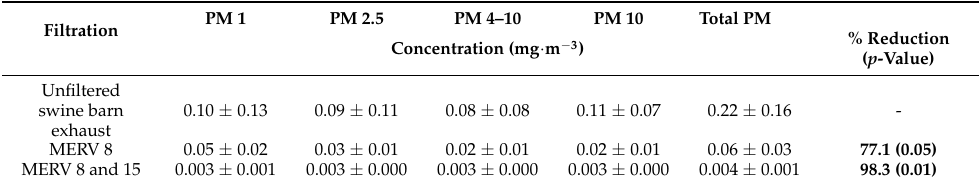
Table 8. Performance of the MERV8 and MERV15 filtration. Values in the table are mean ± S.D. Bold signifies statistical significance. The effluent was used for UV treatment in experiments described in Sections 3.1 and